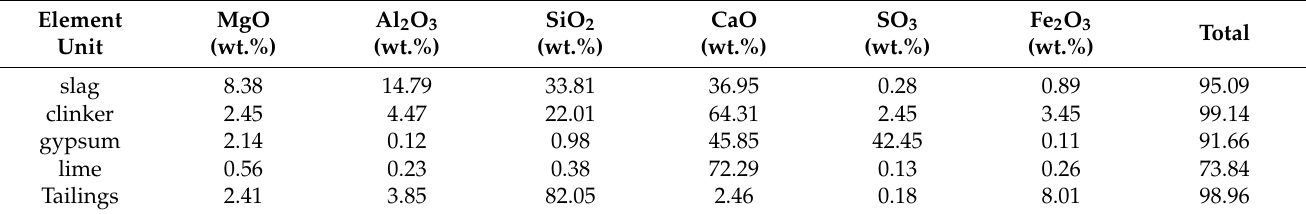
Table 2. Main chemical compositions of NCM and tailings.